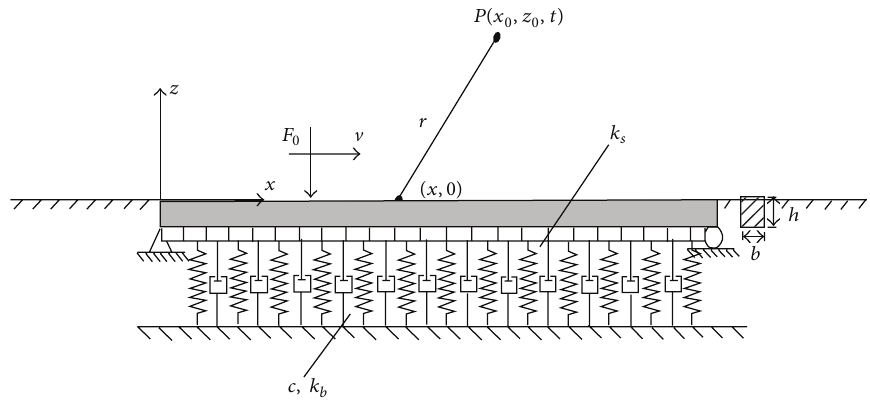
Figure 1: Beam on foundation under moving